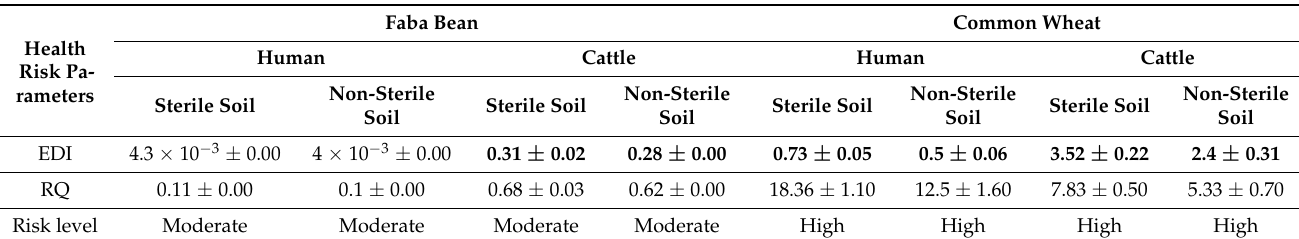
Table 4. Estimated daily intake (EDI; µ g eq MCs kg − 1 of bw d − 1 ) and health risk quotient (RQ) values for humans and livestock (cattle). Data are shown as mean ± standard deviation ( n = 3). Risk level was assessed based on health risk quotient (RQ) values. Bolded values are those higher than the tolerable daily intake (TDI) set at 0.04 and 0.45 µ g kg − 1 of body weight day − 1 for human and cattle,